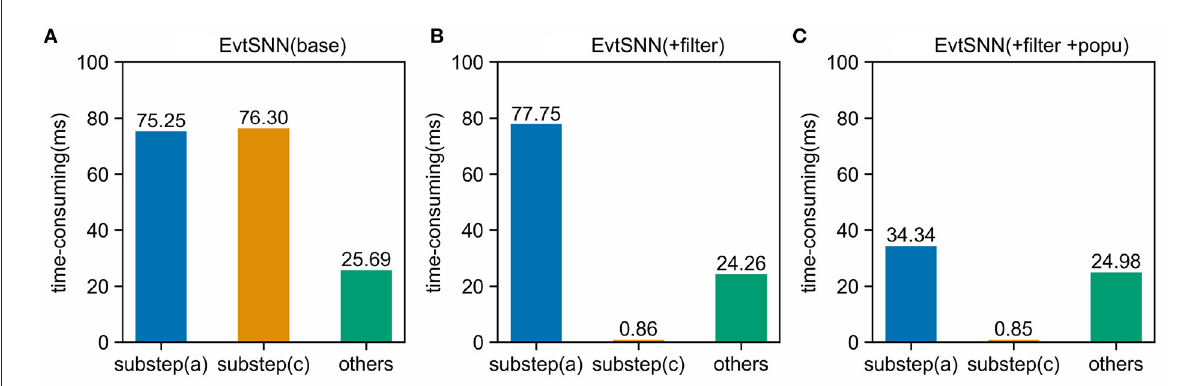
FIGURE10 Time-consuming components in simulation. Using Pre-filtering (+filter) avoids unnecessary computation and can significantly reduce the time-consuming of sub-step (c). Enabling population computing (+popu) avoids repeated calculations and speeds up sub-step (a). (A) EvtSNN